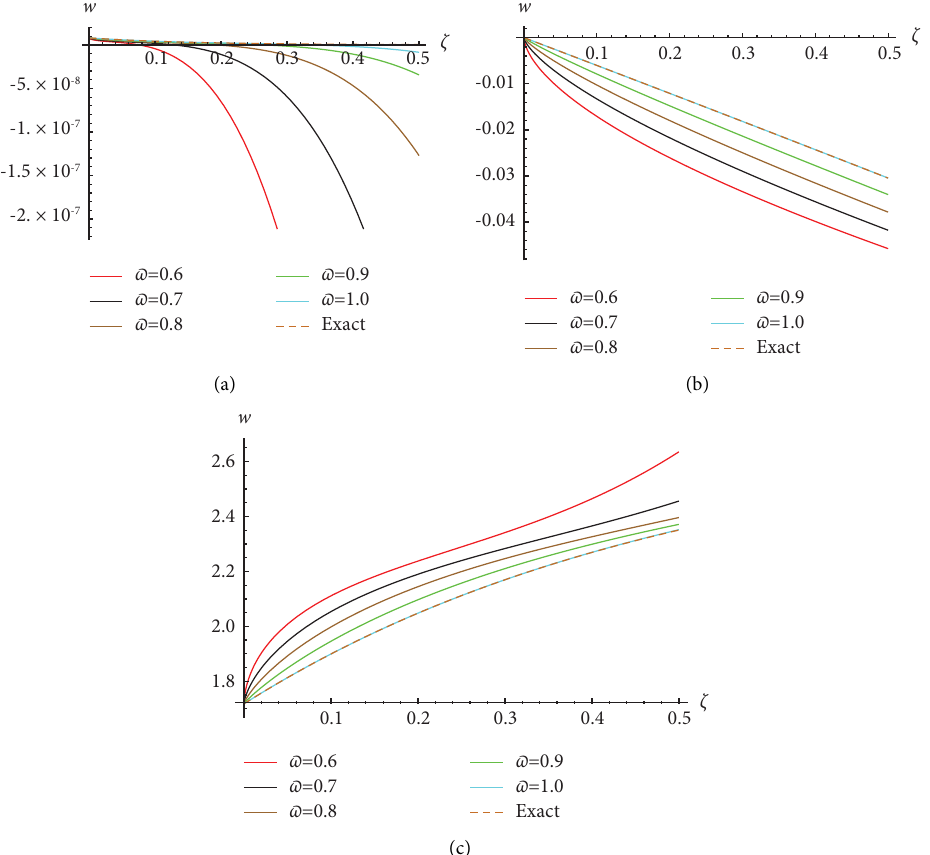
Figure 1: Te approximate result of fve iterations, as well as the exact result of w ( ϰ , ζ ) for various values of ϖ in the range ζ ∈ [ 0 , 0 . 5 ] for (a) Problem 1, when ϰ � 0 . 002, (b) Problem 2, when ϰ � 1 . 0, and (c) Problem 3, when ϰ � 1 . 0 and λ � 2 . 0.